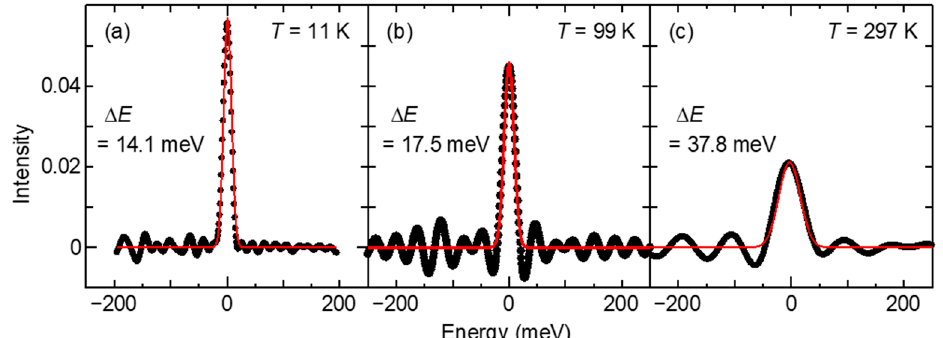
Figure 5. Broadening functions derived from photoelectron spectra of Au(110) measured at liquid helium cooling temperature, T = 11 K ( a ), at liquid nitrogen cooling temperature, T = 99 K ( b ), and at room temperature, T = 297 K ( c ). Each red line shows a fitting result using the Gaussian function with the broadening width Δ E shown.